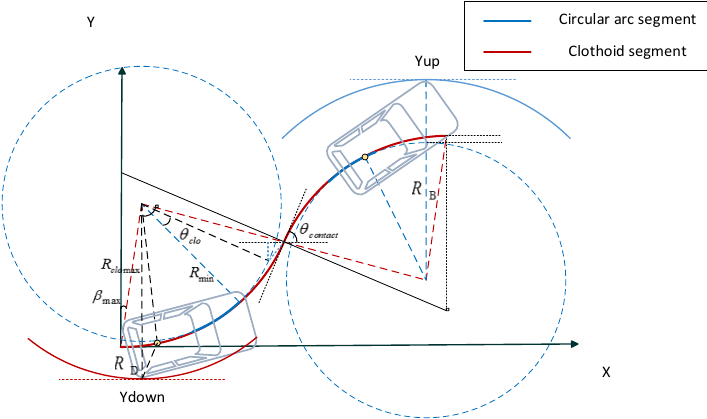
Figure 13. The trajectory of continuous curvature parking.